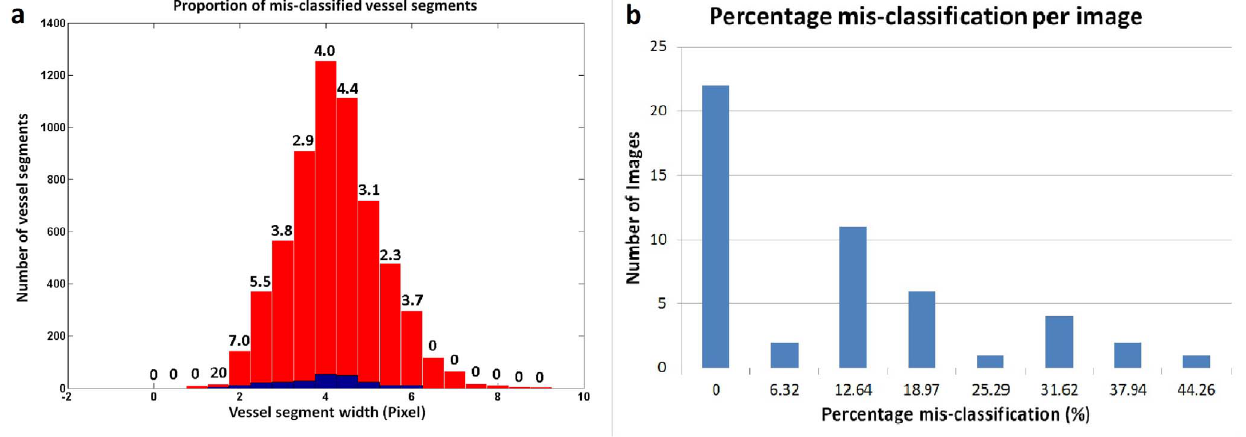
Figure 11. Metrics: a) Proportion of mis-classified vessel segments, b) Percentage mis-classification per image.